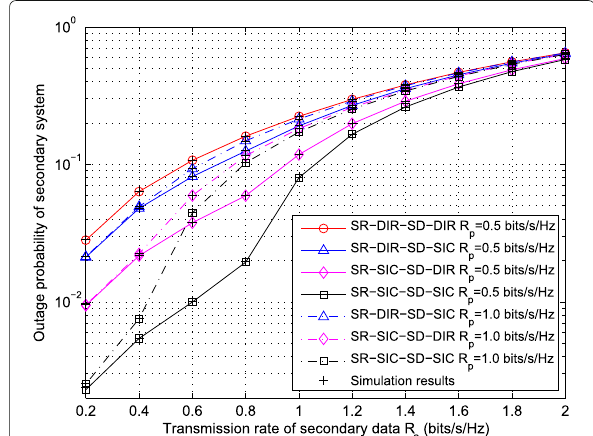
Fig. 9 Outage probability of secondary system vs the transmission rate R s